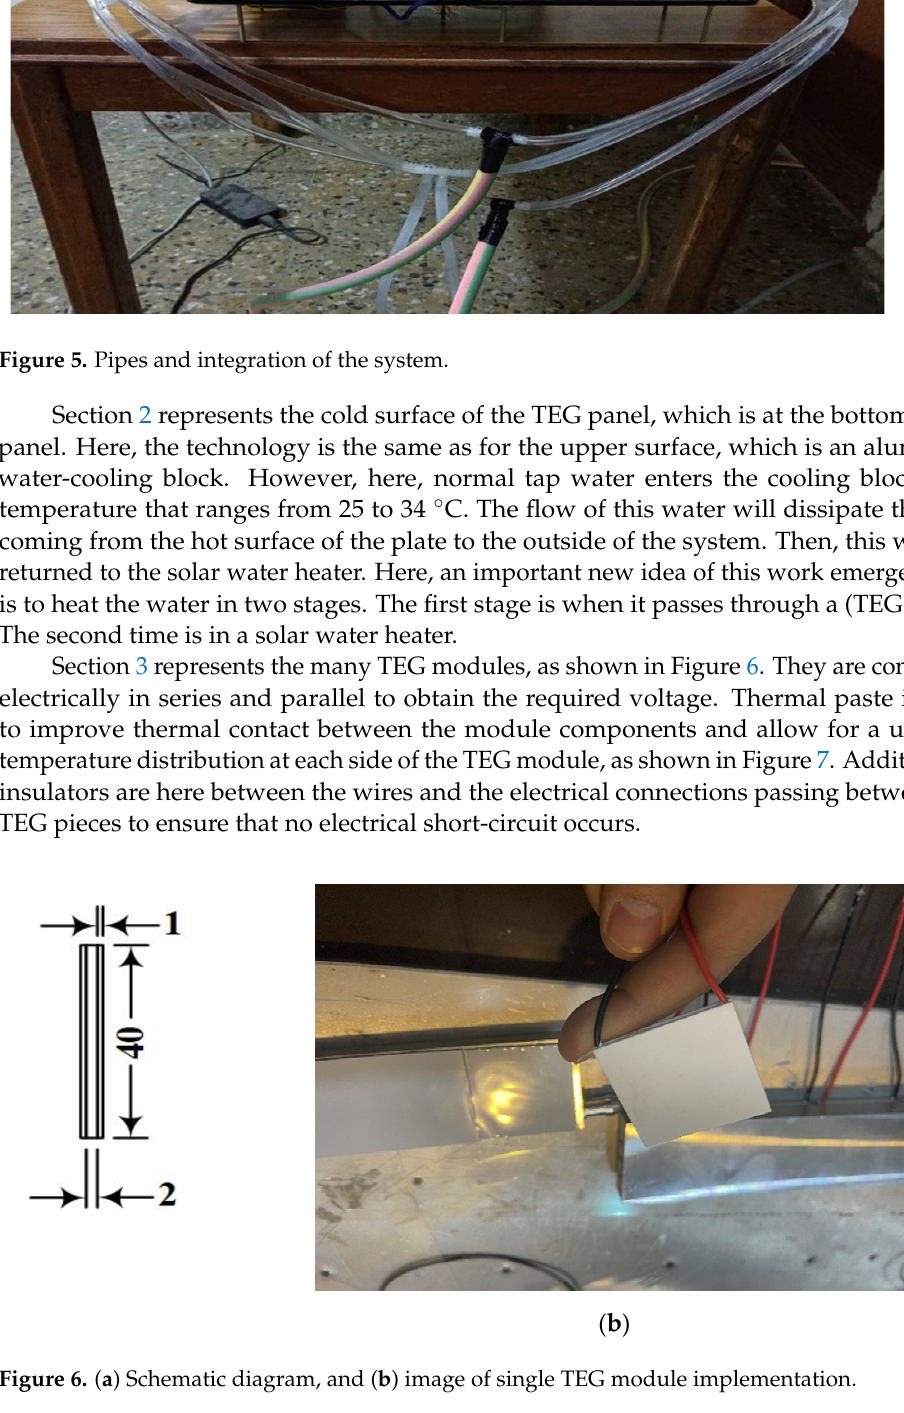
( b ) Figure 4. ( a ) Schematic diagram of CLYXGS aluminum water block, and ( b ) individual pieces com- prising an aluminum water block in the as-built system.